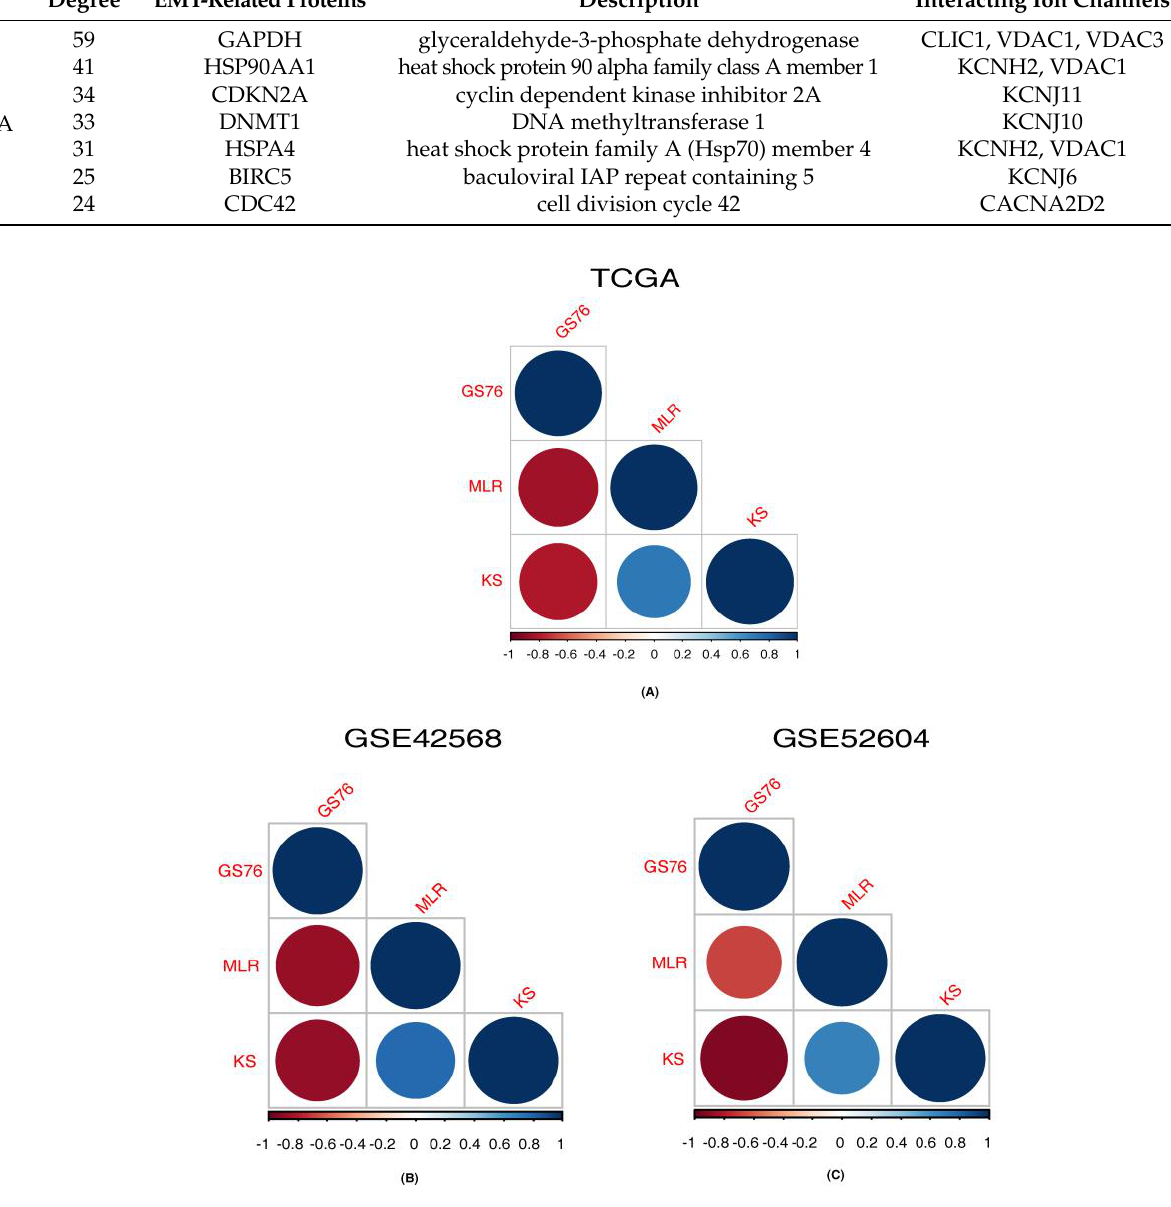
Figure 5. Correlation between GS76, MLR and KS scoring methods for samples from different plat- forms. ( A ) Correlation between GS76, MLR and KS methods for samples from RNA-Seq TCGA data. ( B ) Correlation between GS76, MLR and KS methods for samples from GSE42568 microarray data. ( C ) Correlation between GS76, MLR and KS methods for samples from GSE52604 microarray data.